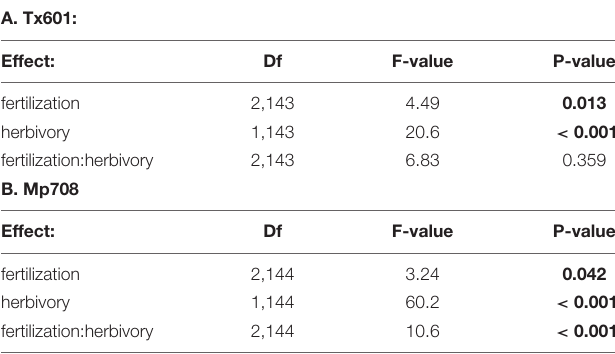
TABLE 2 | ANCOVA table analyzing effects of fertilization treatment, and herbivory on fall armyworm growth for the two maize